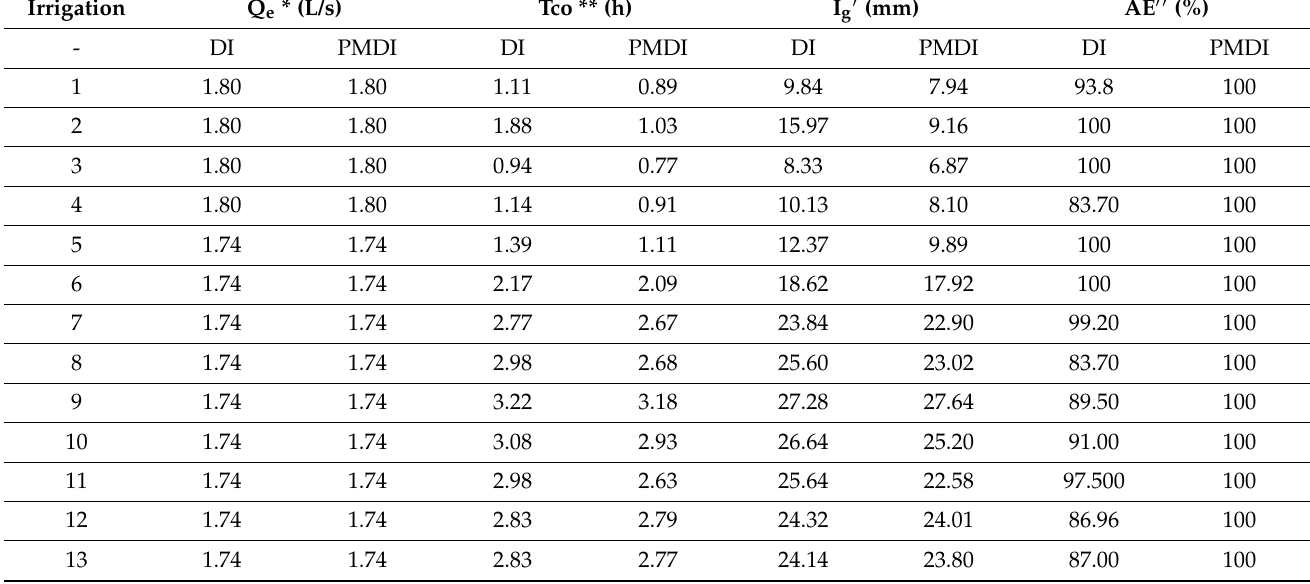
Table 6. Mean values of irrigation parameters